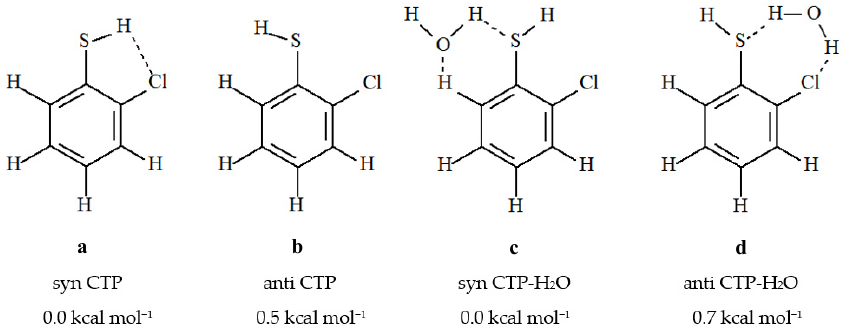
Figure 2. Syn- and anti-conformers of CTB ( a , b ) and CTB-H 2 O ( c , d ). Figure 2. Syn ‐ and anti ‐ conformers of CTB ( a , b ) and CTB ‐ H 2 O ( c , d ).